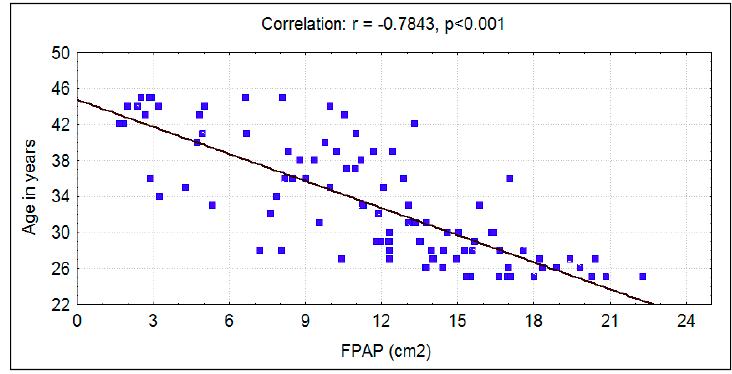
Figure 1. Correlation between age in years with fungiform papillae count (FPAP) (per cm 2 ) in smokers.